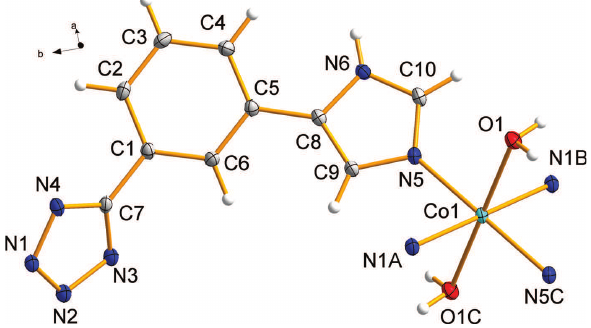
Table 1: Data collection and handling.